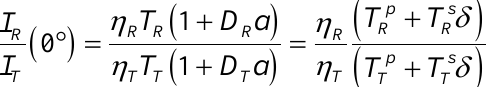
for the linear depolarisation ratio δ if we know the calibration factor